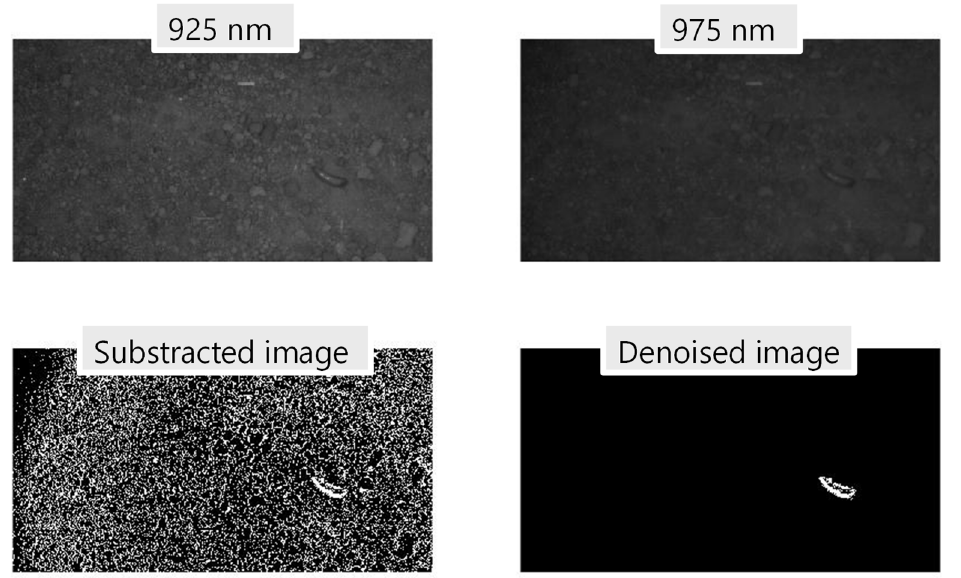
Figure 9. Result of the detection methodology in this study.